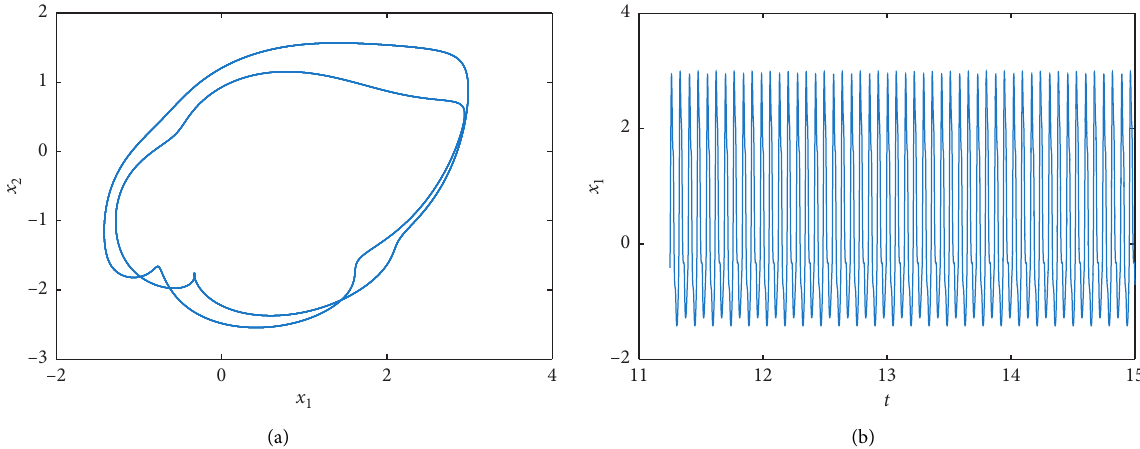
Figure 9: Phase portrait on plane ( x motion when P